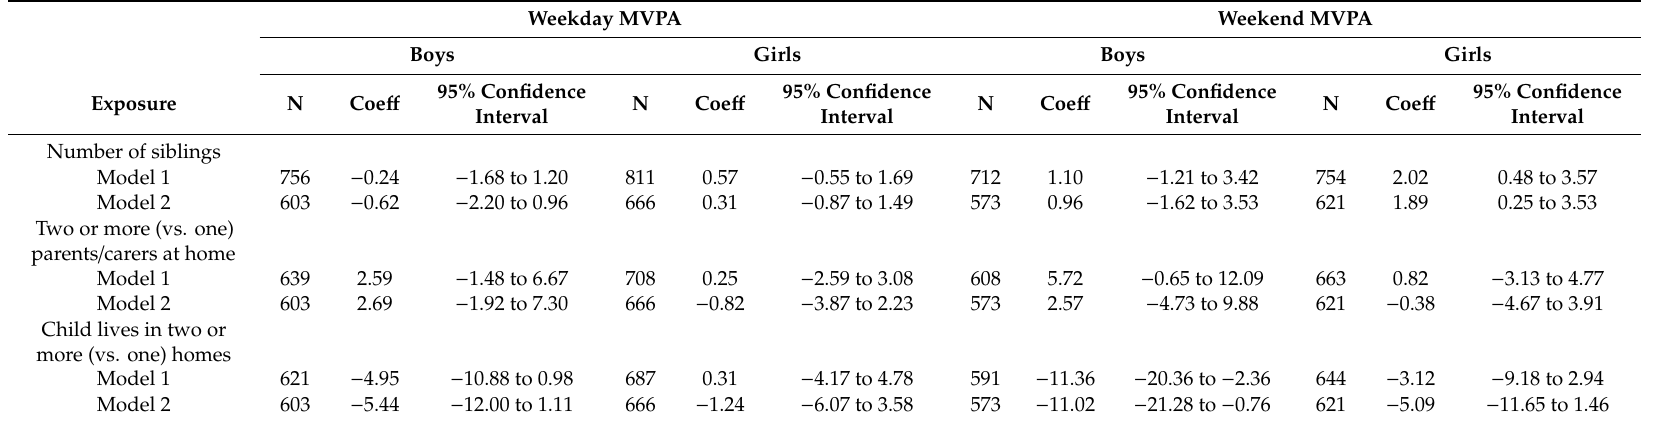
Table 6. Longitudinal associations of weekday and weekend MVPA with family structure variables between age 6 and 11. Weekday MVPA Weekend MVPA Boys Girls Boys